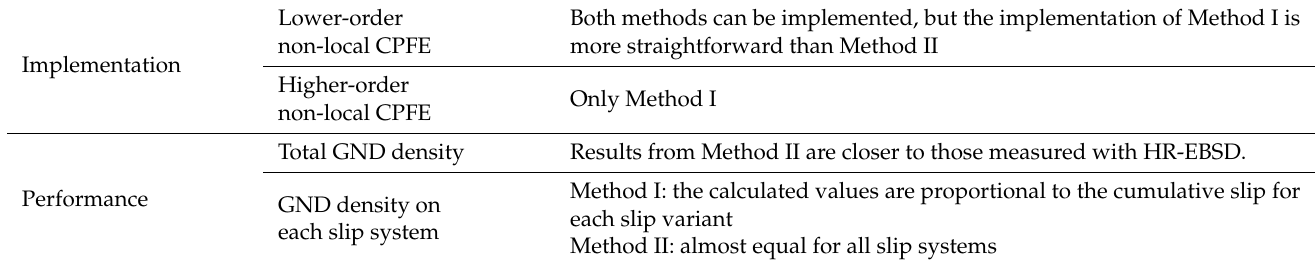
Table 3. A comparison between Method I and II for determining GND